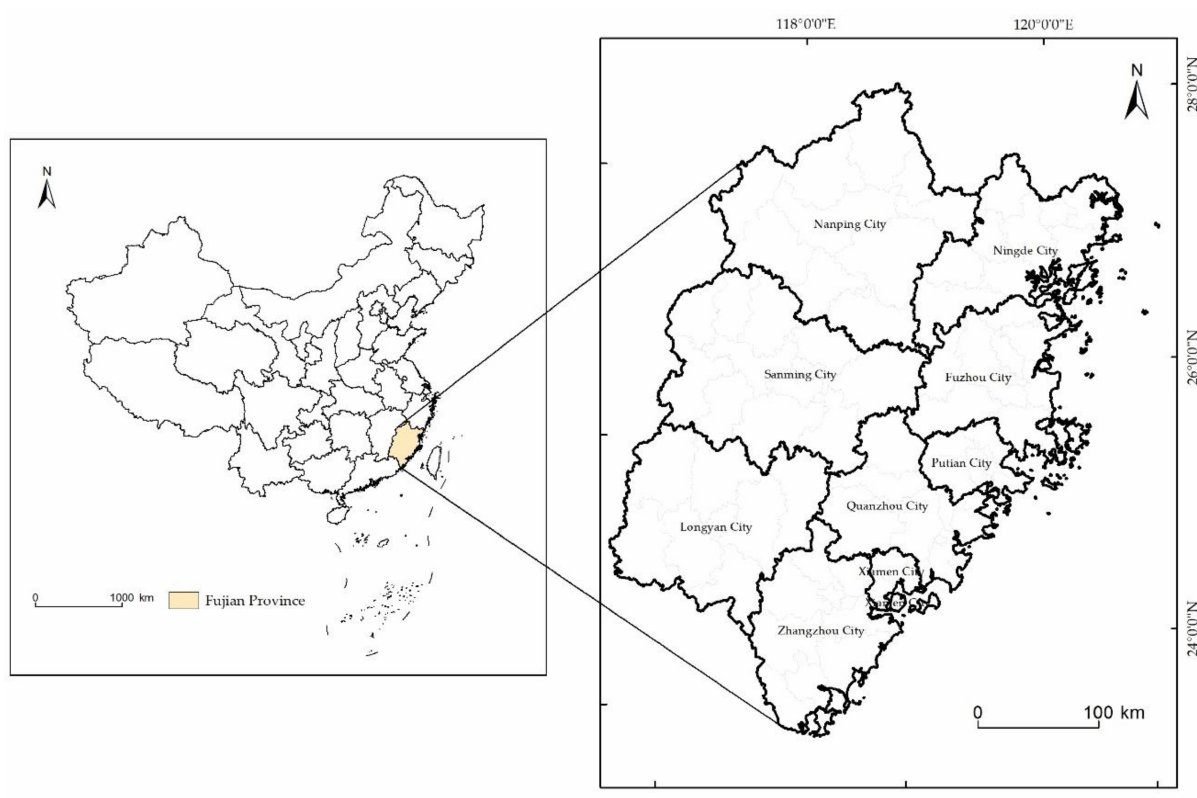
Figure 1. Location of the study